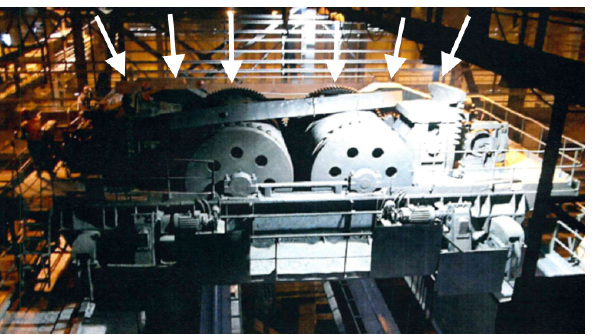
Figure 5. Photography of the gantry drive system—the approximate location of the sensors is indicated by arrows.